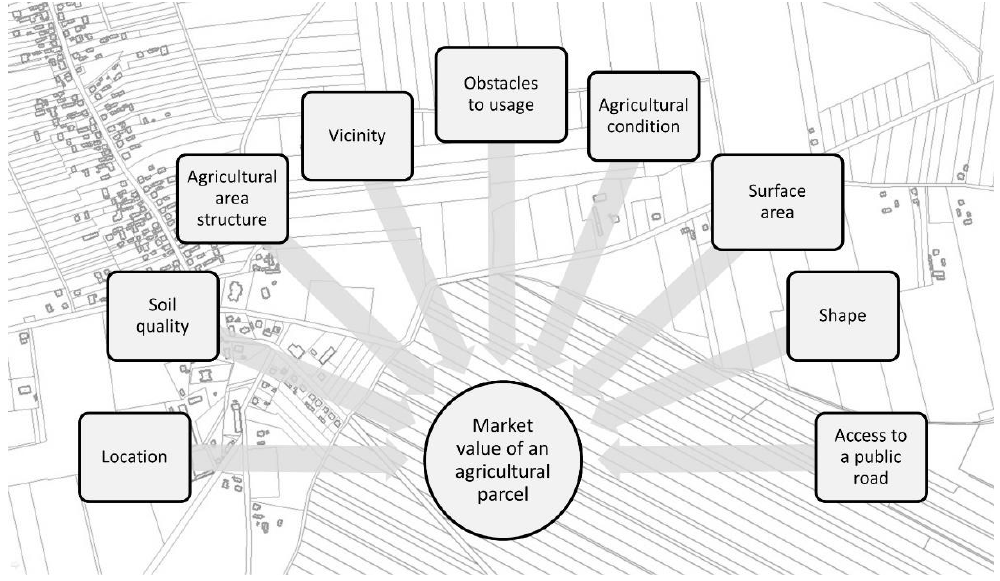
Figure 1. Factors and features affecting the market value of agricultural parcels taken into consideration in market analysis (including analyzed features that change as a result of consolidation projects: surface area and shape of a parcel and access to a public road).